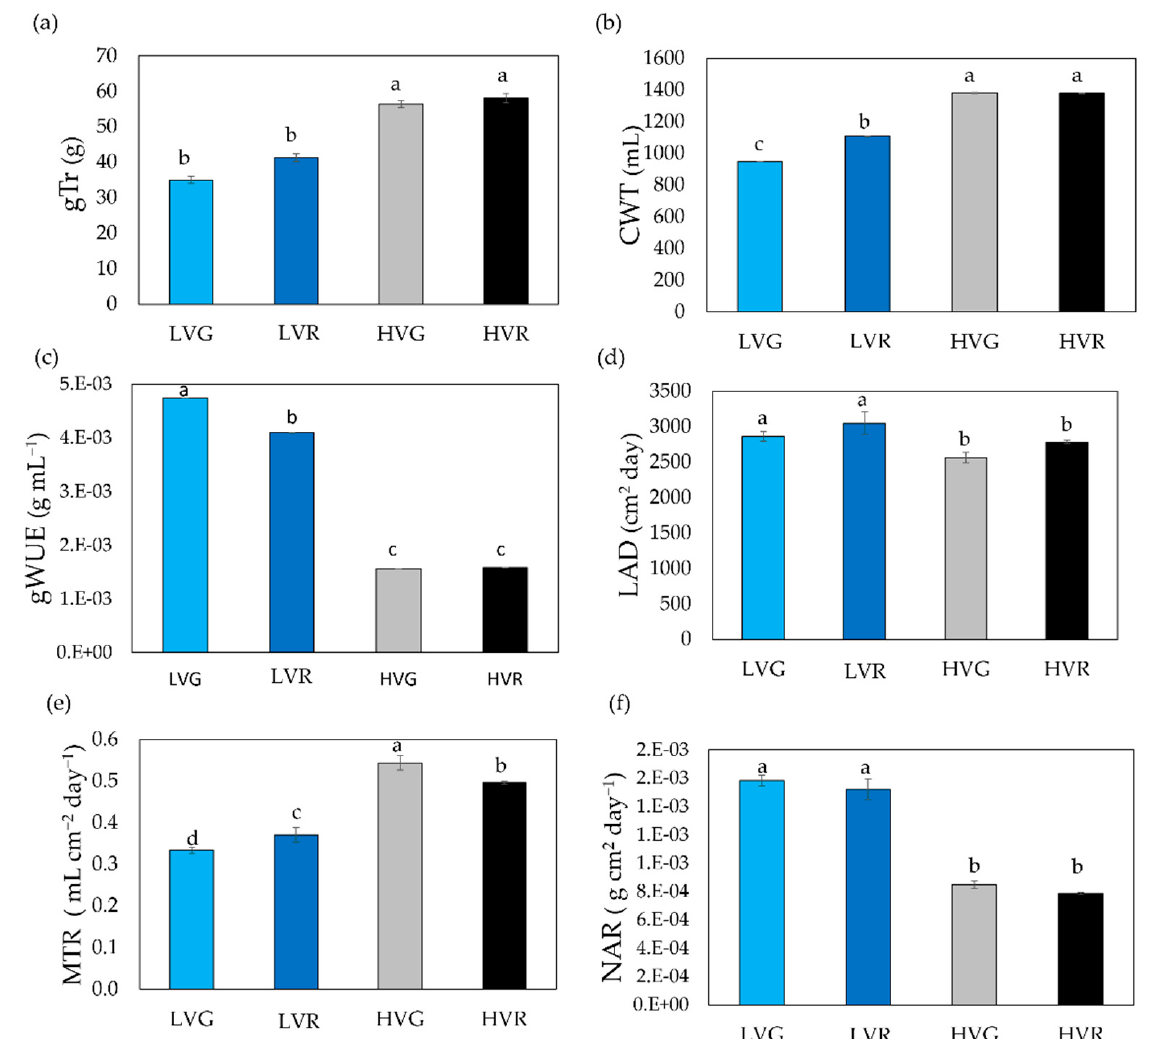
Figure 4. Gravimetric indexes of green (G) and red (R) lettuces under low (LV) and high (HV) VPD: transpiration (gTr; ( a )), cumulative water transpired (CWT; ( b )), water use efficiency (gWUE; ( c )), leaf area duration (LAD; ( d )), mean transpiration rate (MTR; ( e )) and net assimilation rate (NAR; ( f )). Mean values (n = 9) ± standard errors are shown. Different letters correspond to significantly different values among treatments, according to Tukey’s HSD ( p ≤ 0.05).